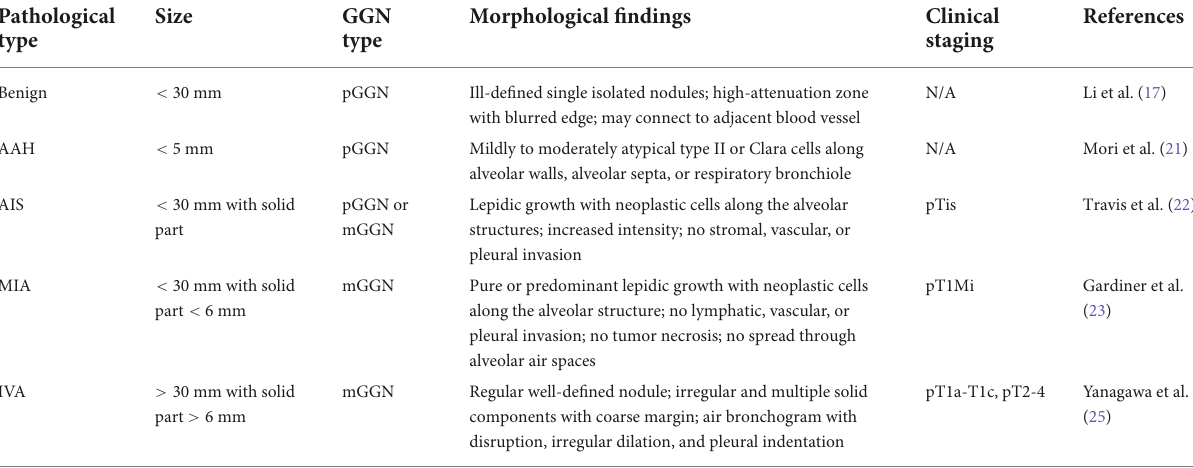
TABLE 1 The characteristics of benign and malignant